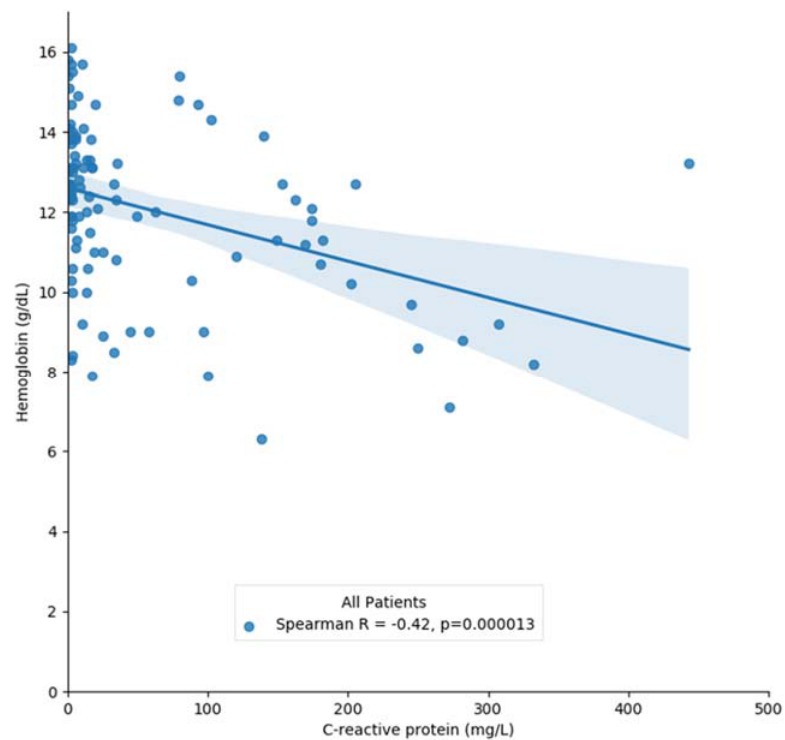
Figure 1. Correlation between hemoglobin and C-reactive protein concentrations in the entire cohort.